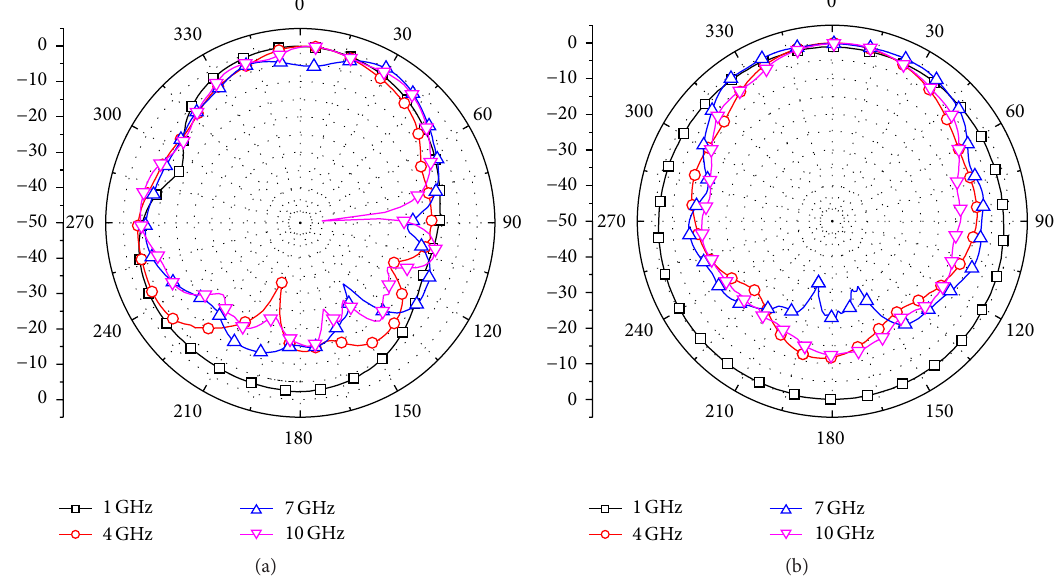
Figure 9: Normalized measured radiation patterns for proposed antenna:(a) 𝐸 -plane and (b) 𝐻 -plane.